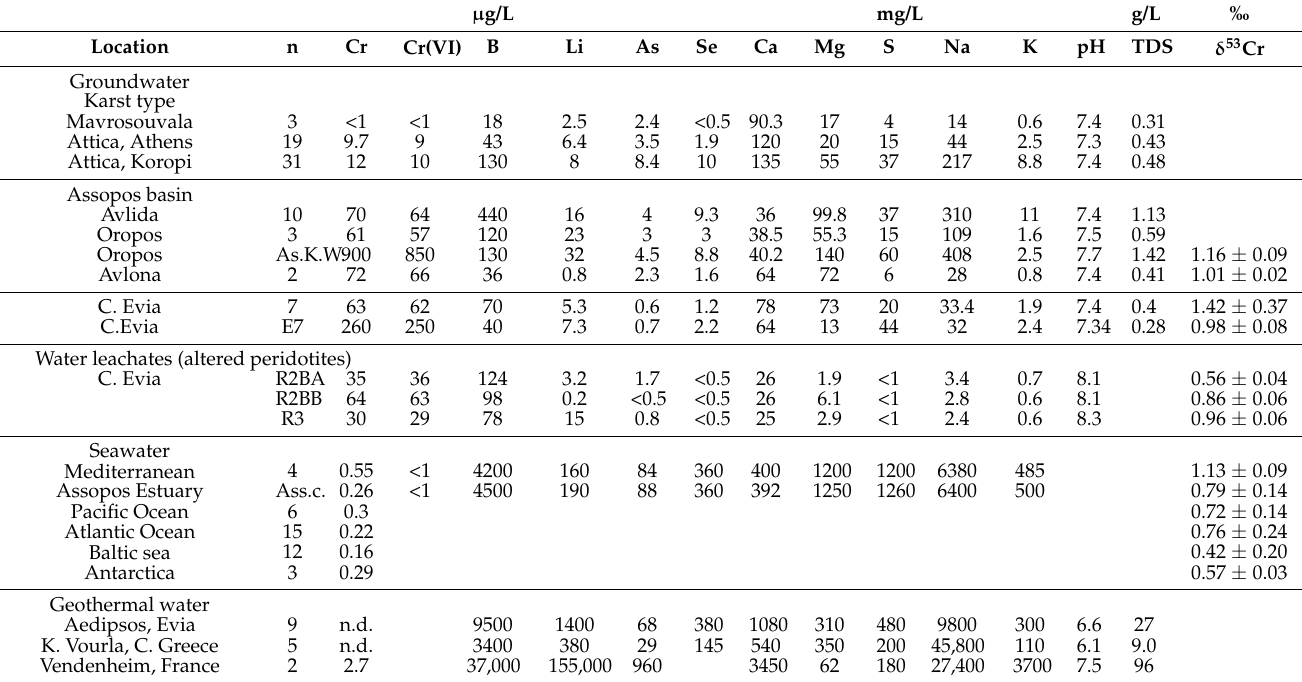
of the method (0.2 µ g/L). The Pt was lower than detection limit (0.01 µ g/L) in the Attica aquifers, while 0.01 values were measured in the C. Evia and Assopos aquifers. The Ru concentrations ranged from 0.06 to 0.3 µ g/L in Attica, and from 0.06 to 0.19 µ g/L in the C. Evia and Assopos Basins (Table 1). Additionally, these water samples were analyzed for the elements Au, Ag, Al, Ti, W, Tl, Te, Ta, Sn, In, Hf, Ge, Pb, Cs, Hg, Be, Bi, Cd, Ga and Y, but their concentrations were lower than the detection limit of the method. The measured concentrations for REEs and PGEs in water leachates for altered peridotites were also too low (Table 1). The available data on groundwater from previous studies exhibiting the lowest B and Cr(VI) concentrations have been recorded in the Mavrosouvala wells of karst type (Table 2), which are used for the municipal water supply of Athens city. Table 2. Average composition of groundwater from the Assopos, Thiva, Attica Basins and C. Evia and seawater. Data from refs